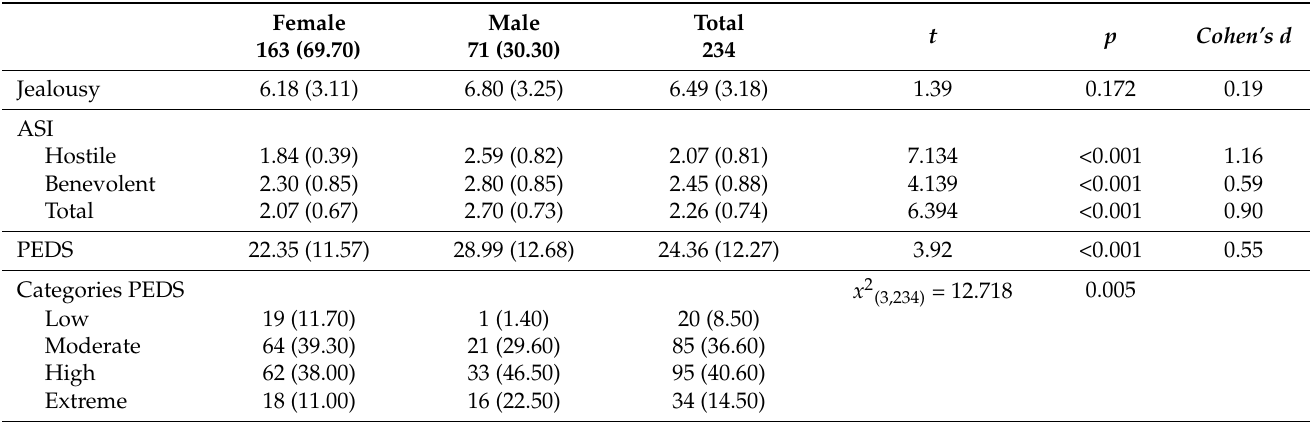
Table 2. Scores obtained on the jealousy subscale, emotional dependence, ambivalent sexism, and categories of the partner emotional dependence scale according to the gender of the participants.